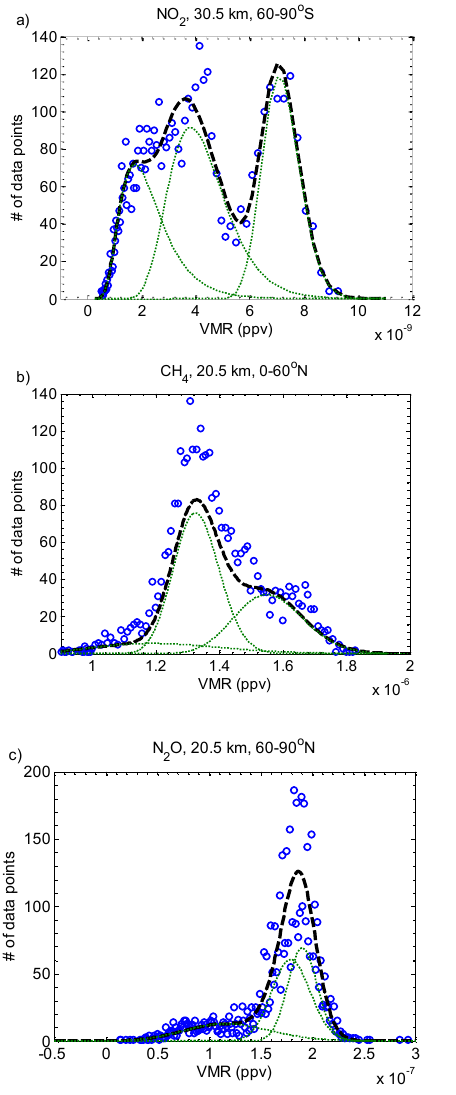
Figure 4. Sunrise ACE-FTS VMR distribution (blue circles) and fitted EDF (black dashed lines) for: (a) NO 2 at 30.5km in the lat- itude region 60–90 ◦ S; (b) CH 4 at 20.5km, 0-60 ◦ N; and (c) N 2 O at 20.5km, 60–90 ◦ N. The dotted green lines are the fitted Gaussian distributions in calculating each of the EDFs, and the fitted distribu- tions have been normalized to the measured VMR distributions.